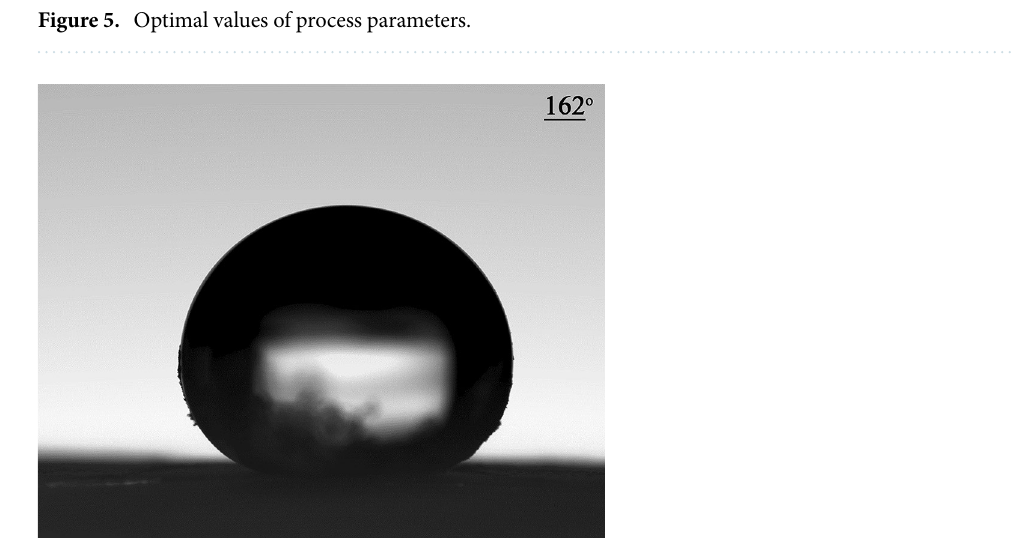
Figure 6. Contact angle between the drop and the glass